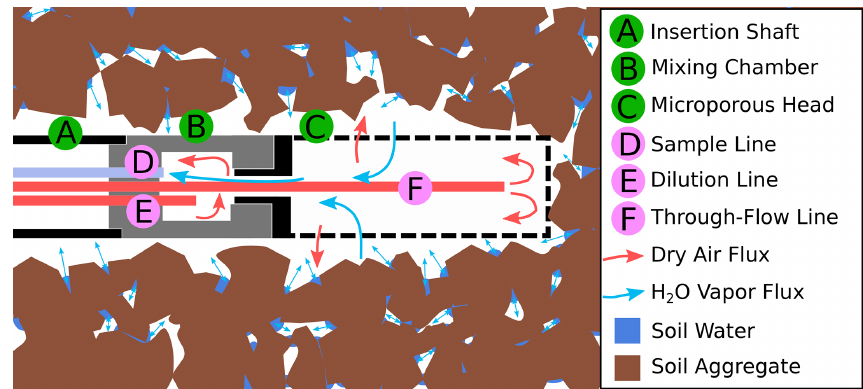
Figure 3. Sketch of a WIP installed in soil. Water vapor from the surrounding medium (in this case soil) diffuses through the microporous membrane into the probe head (C). Before being sucked into the sample line (D), the sample gas is diluted within the mixing chamber (B).